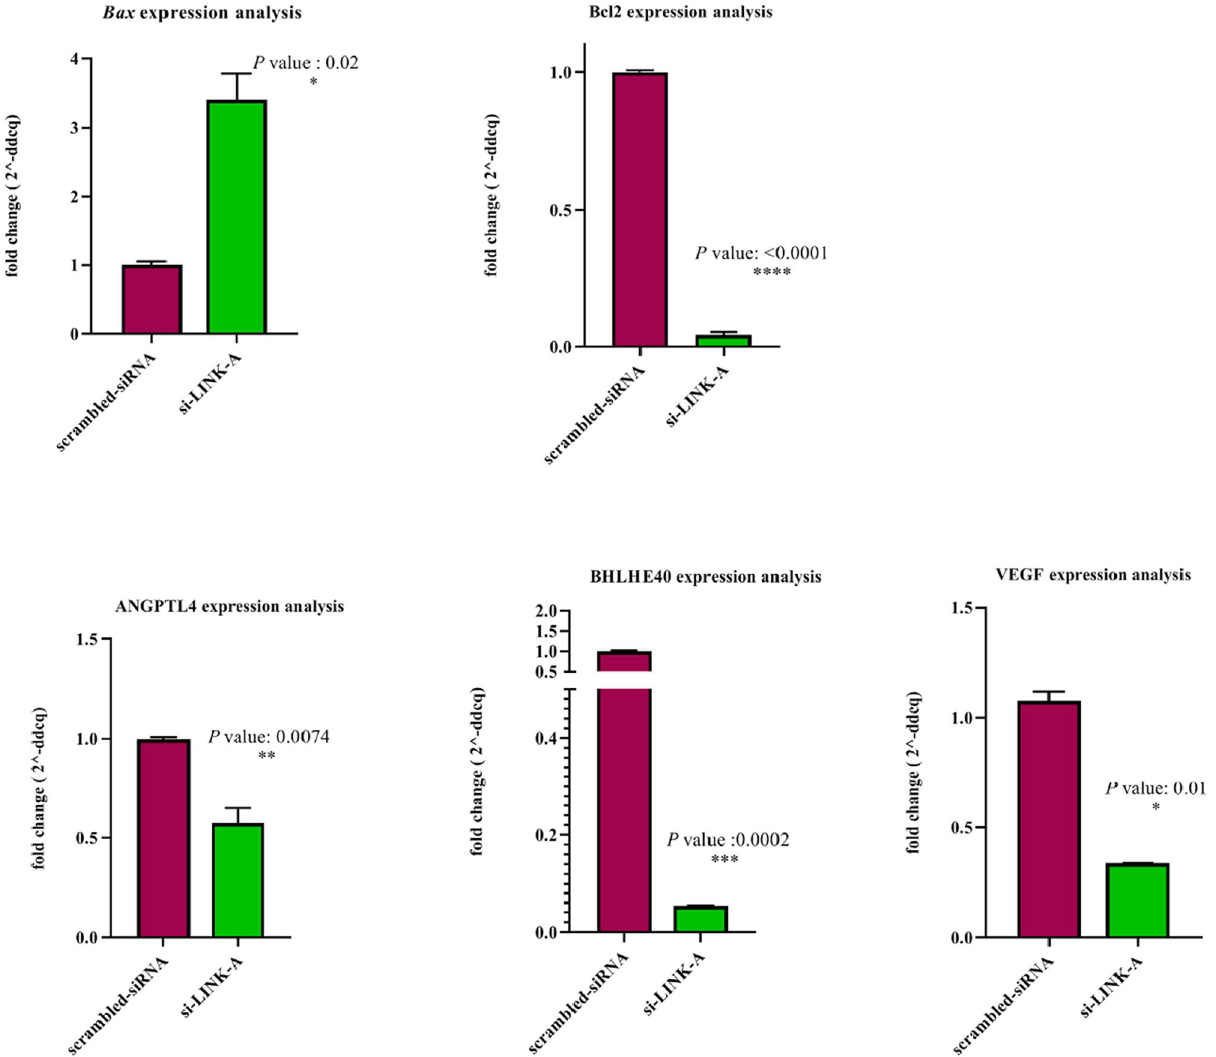
Figure 7. Graph bars of Real time PCR. RNA expression changes of VEGF , ANGPTL4 , BHLHE40 , BAX , BCL2 in LINK-A down-regulated A549 cells. Data are presented as mean ± Sd. Two-tailed student’s t-test analysis was performed for each gene separately (* P < 0.05, ** P < 0.01, *** P <